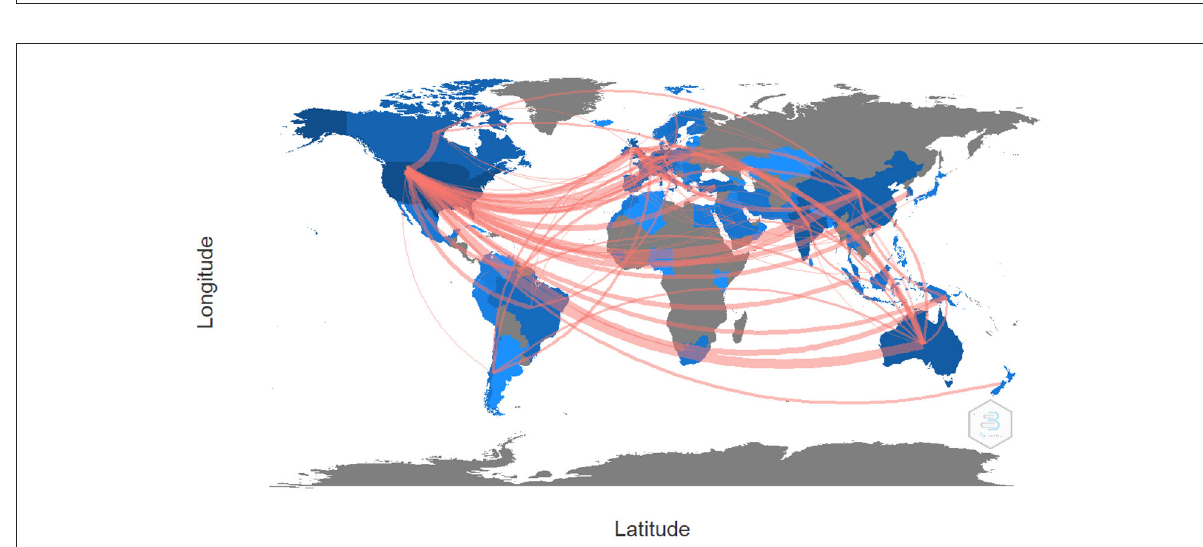
FIGURE10 Map of collaboration between countries. Source: Own elaboration using Bibliometrix.